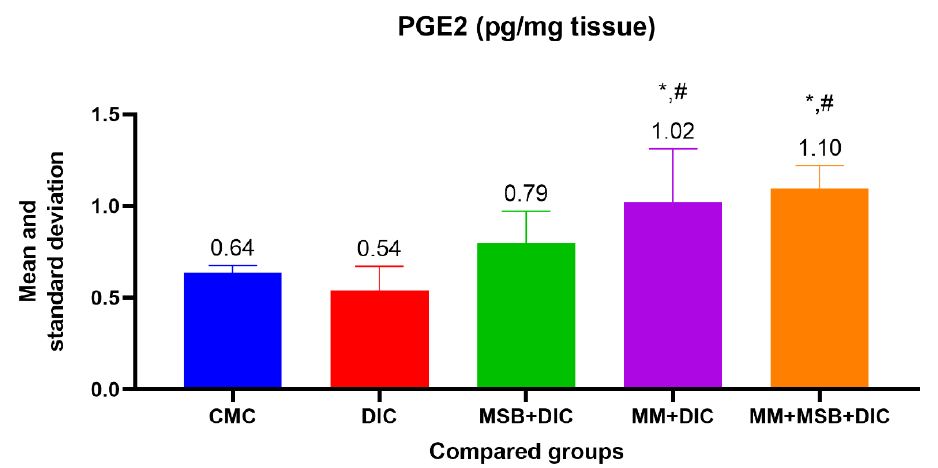
Figure 1. The mean value and standard deviation of PGE2 between the analyzed groups. Group I-CMC, negative control group; group II-DIC, disease control group; group III-MSB+DIC, group receiving MegaSporeBiotic; group IV-MM+DIC, group receiving MegaMucosa; group V-MM+MSB+DIC, group receiving MegaSporeBiotic and MegaMucosa; *, p < 0.05 compared with group II (DIC); #, p < 0.05 compared with group I (CMC). For the iNOS variable, the ANOVA test was statistically insignificant ( p = 0.34); thus, there is no statistically significant difference between the groups (Figure 2).